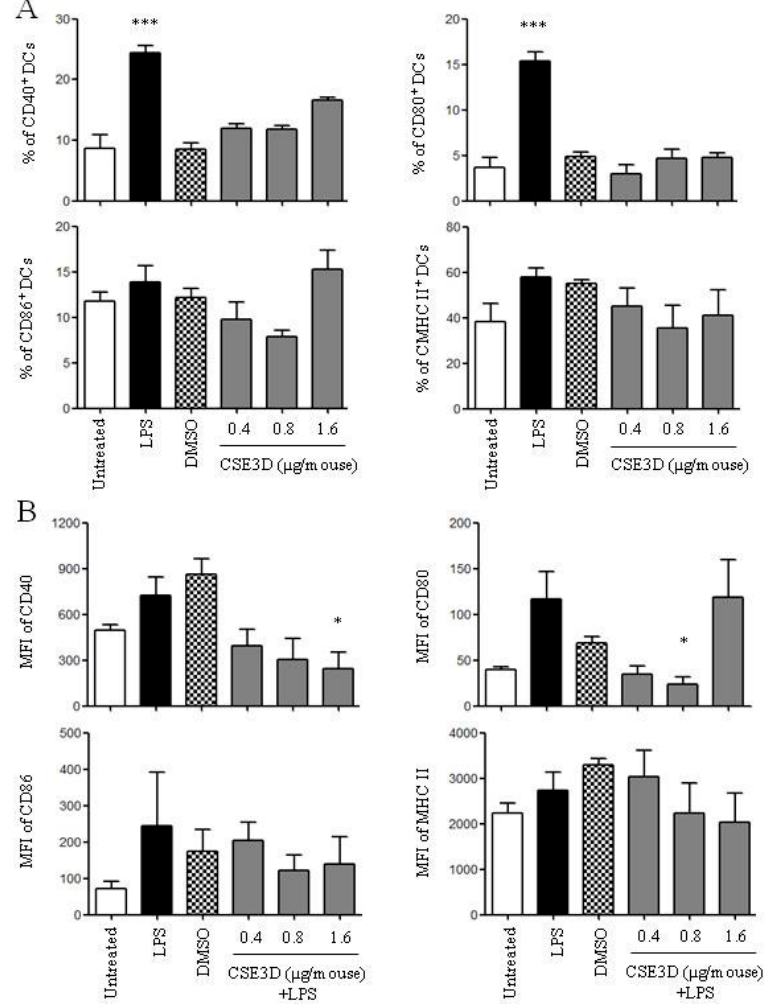
Figure 6. CSE3D suppressed DC maturation induced by LPS in vivo. Mice were injected with different concentrations of flavonoids in CSE3D in the absence ( A ) or presence ( B ) of LPS by footpads. After 24 h, lymphocytes were isolated to analyze DC maturation. CD11c + cells were gated to analyze the expressions of CD40, CD80, CD86, and MHC II. MFI of these molecules is shown. *** p < 0.001 compared to untreated mice. * p < 0.05 compared to LPS treated mice.